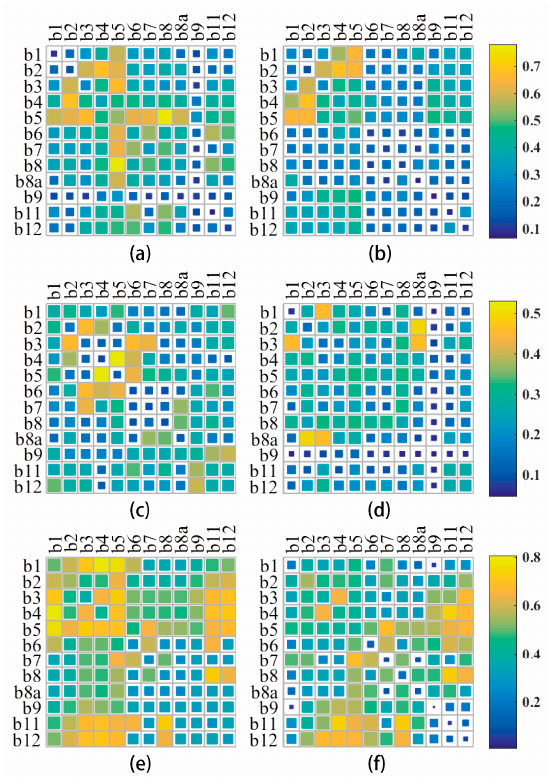
Figure 6. The correlation coefficient matrix of water quality parameters with bands and band combinations. The X and Y axes are the respective bands of the image: ( a,c,e ) super-resolution image; ( b,d,f ) resampling image by nearest-neighbor method. ( a,b ) NH 3 -N; ( c,d ) Chemical Oxygen Demand (COD); ( e,f ) Total Phosphorus (TP). Relation of 0.6 > R > 0.4 is significant at the 0.05 level, and the